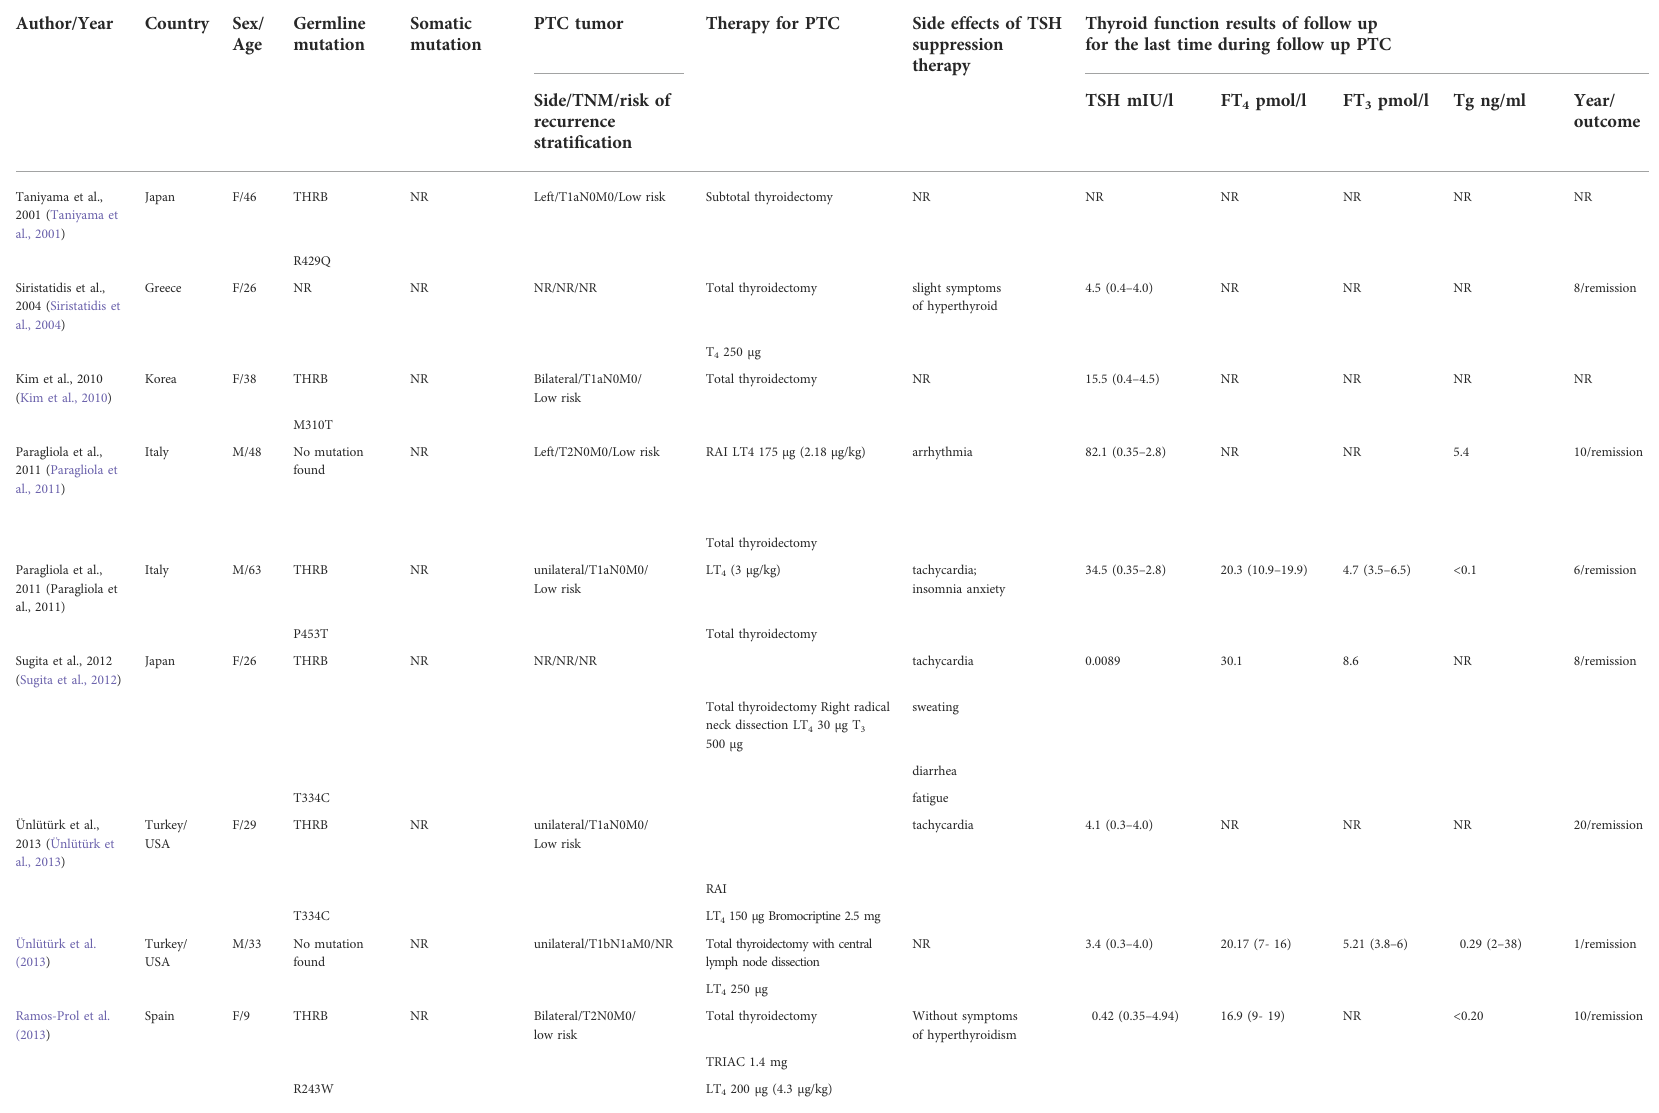
TABLE 3 Review of cases of resistance to thyroid hormone coexisting with papillary thyroid